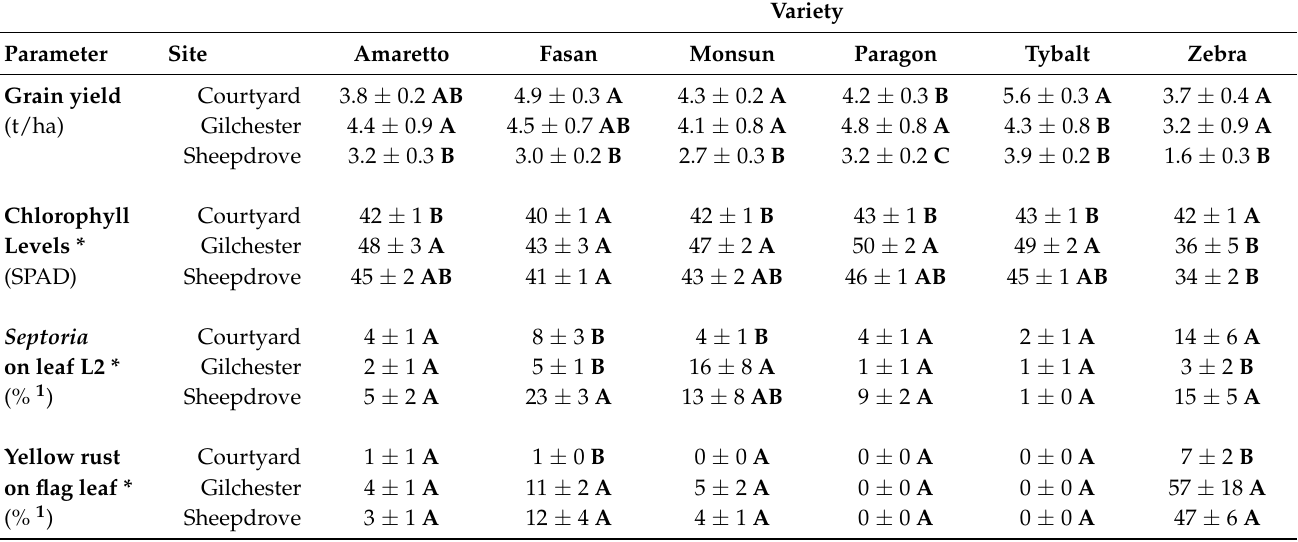
Table 8. Interaction means ± SE and ANOVA results ( p -values) for the effects of site (three contrasting locations in the UK) and variety on grain yield, leaf chlorophyll levels (SPAD), Septoria and yellow rust disease severity, grain protein content and quality, and grain Zn and Fe concentrations in spring wheat ( T. aestivum ) grown under organic management